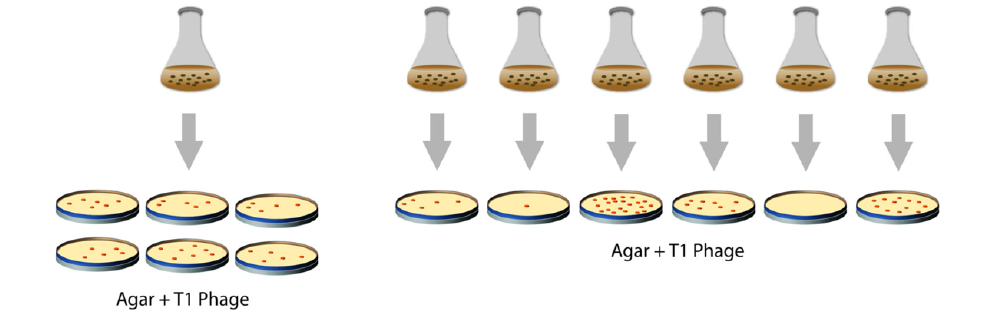
Figure 2. The Luria and Delbrück experiment. In 1943, Luria and Delbrück devised an experiment to address whether mutations occur prior to selection or in response to it (‘spontaneous mutation’ versus ‘directed mutation’). Figure modified from [26] under the Creative Commons CC BY